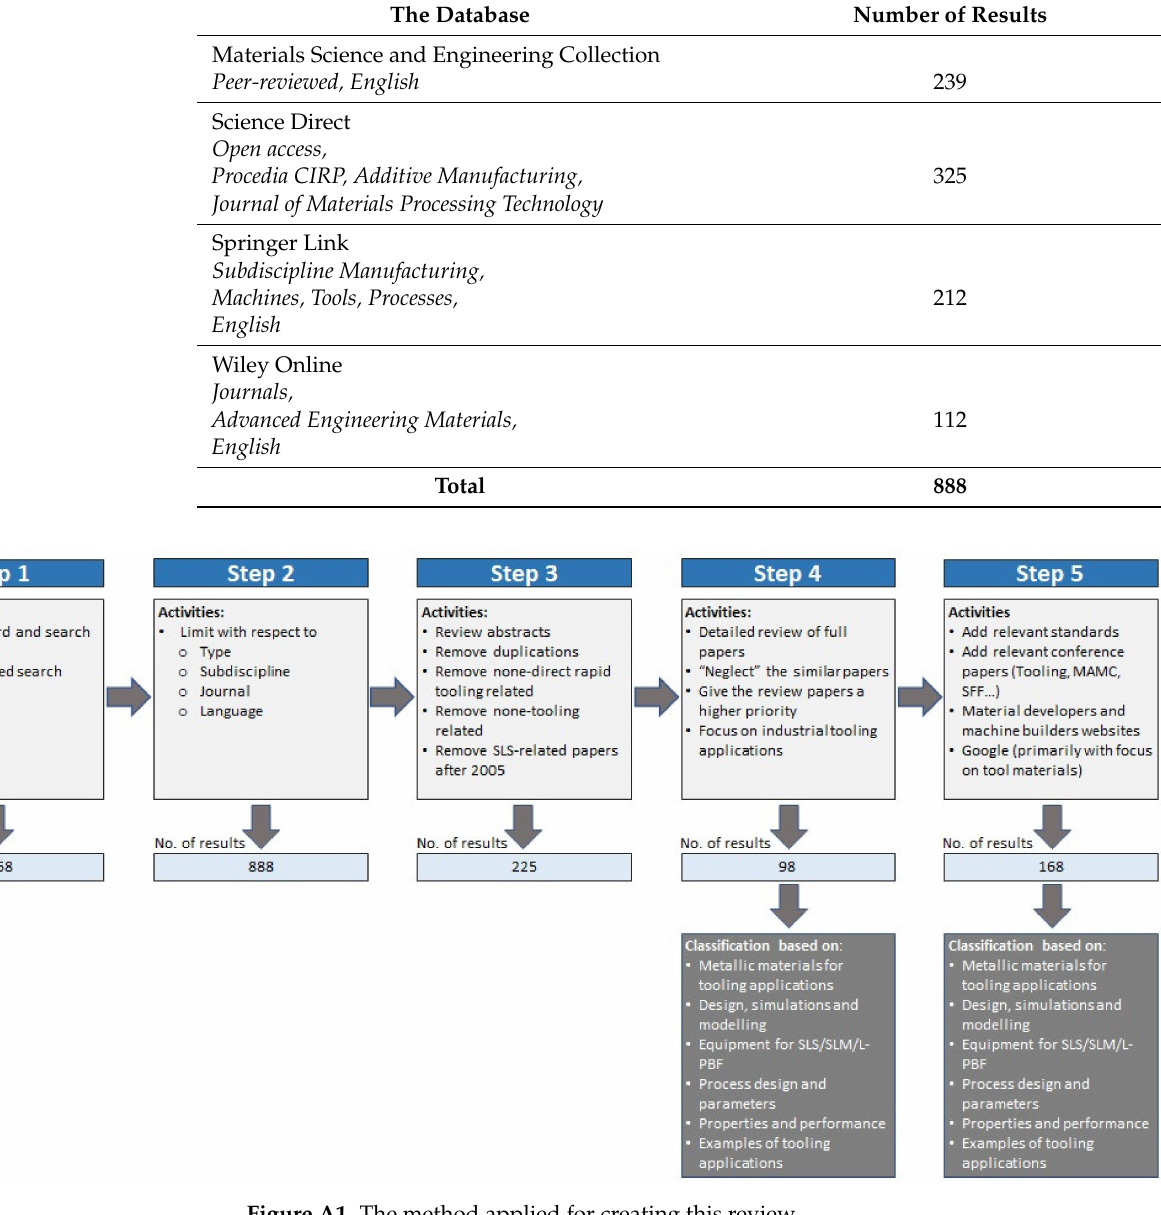
Figure A1. The method applied for creating this